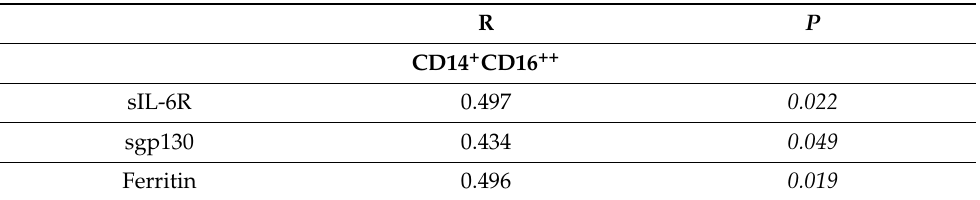
Table 3. Correlation of CRT-induced monocyte CD14 + CD16 ++ nonclassical subset changes with changes in selected biochemical